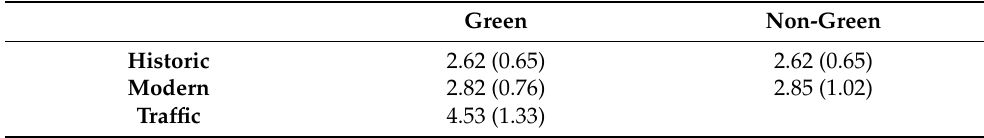
Table 4. Mean scores (SD) for stress in environment